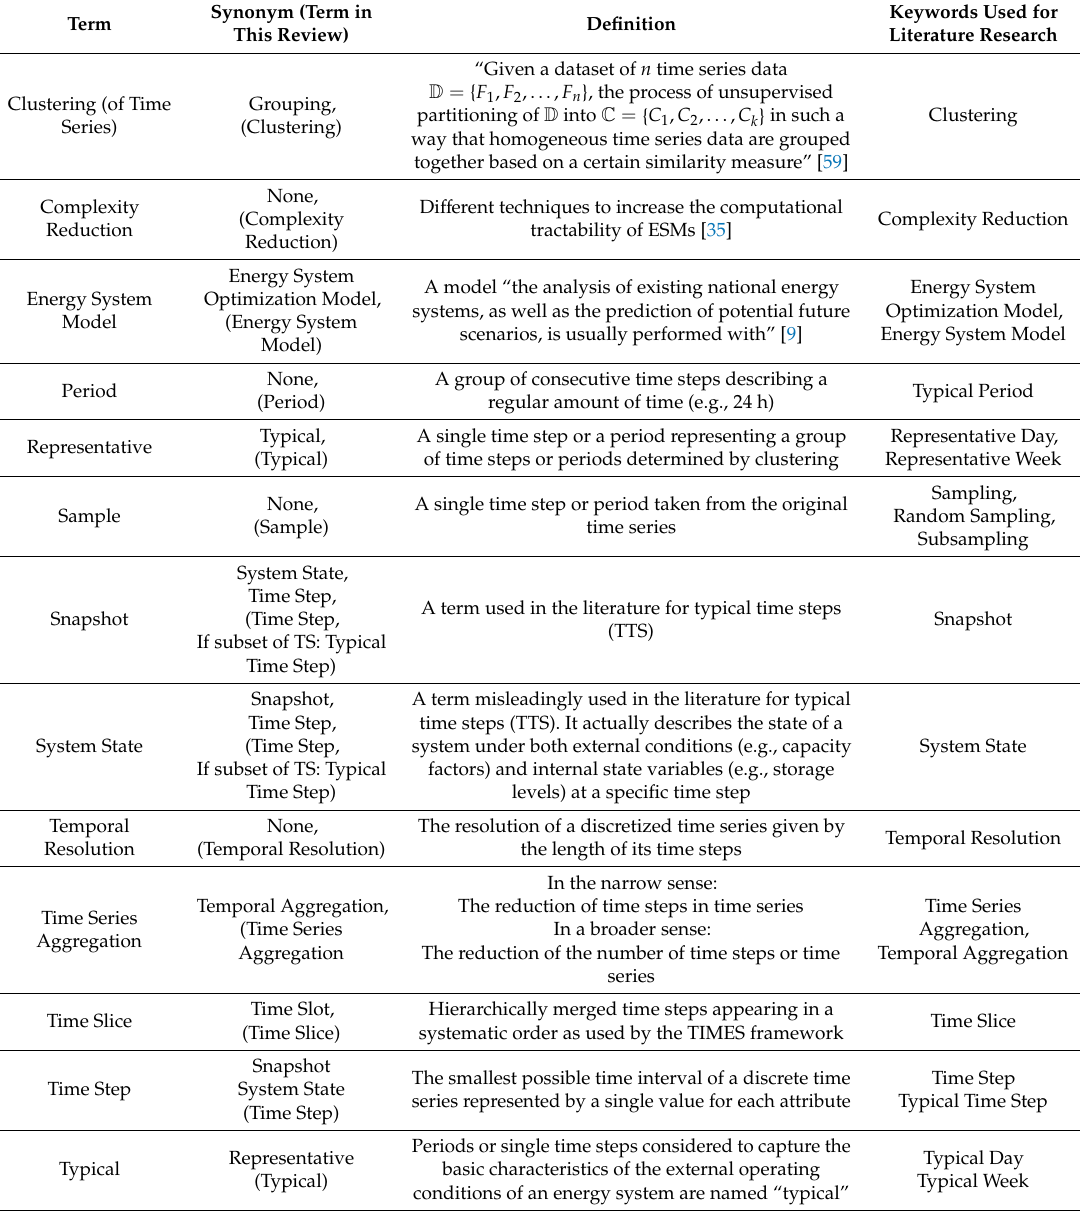
Table 1. Glossary and simultaneous keyword list used for the literature